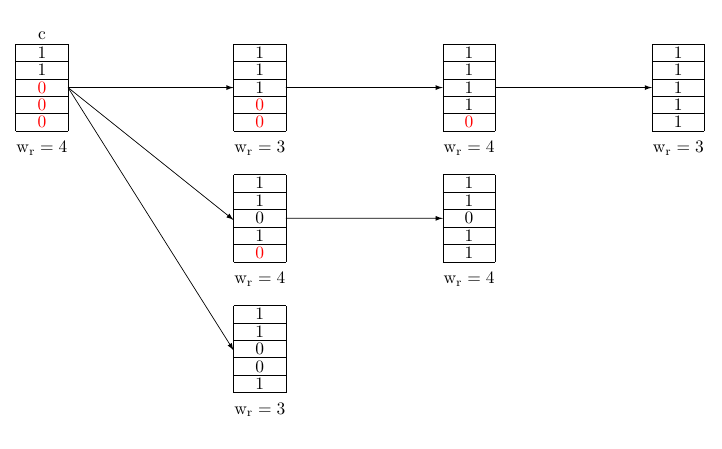
Figure 5: The score of a column difference with the first two stable bits set to (1 , 1) is 3.